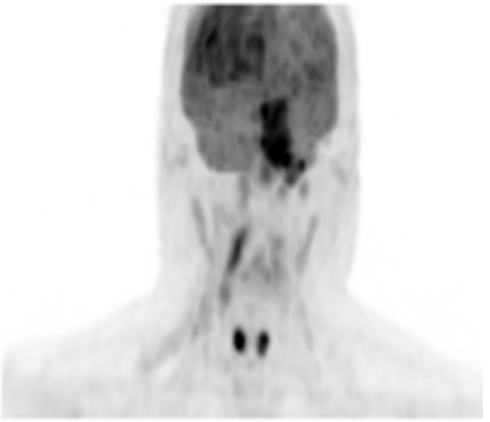
Figure 2. PET scan image at diagnosis in 7 July 2019.